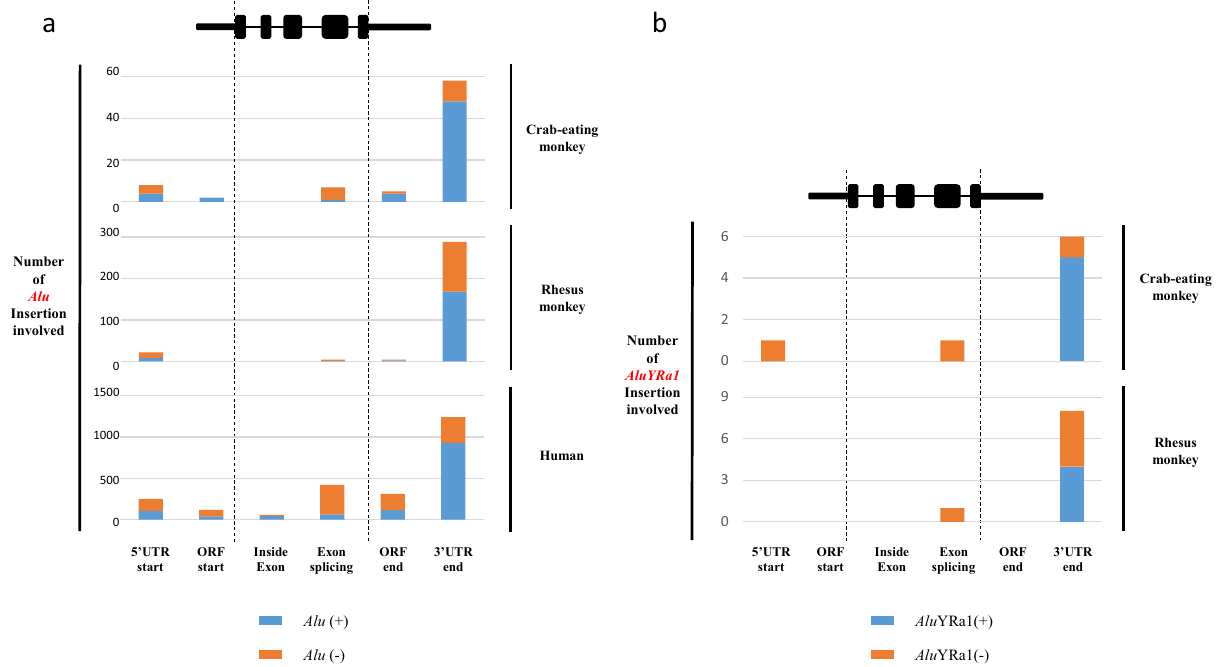
Figure 5. Calculation of repeat element position in three genomes: cynomolgus macaque, rhesus macaque, and human. A self-devised locator was utilized to provide the output data in a certain format, and the graphs are based on results of the statistical sorting of the output file for cynomolgus macaque, rhesus macaque, and humans. ( a ) Alu detailed position information. ( b ) Alu YRa1 position information. Blue and orange bars represent the inserted repeat element in sense and antisense orientation,